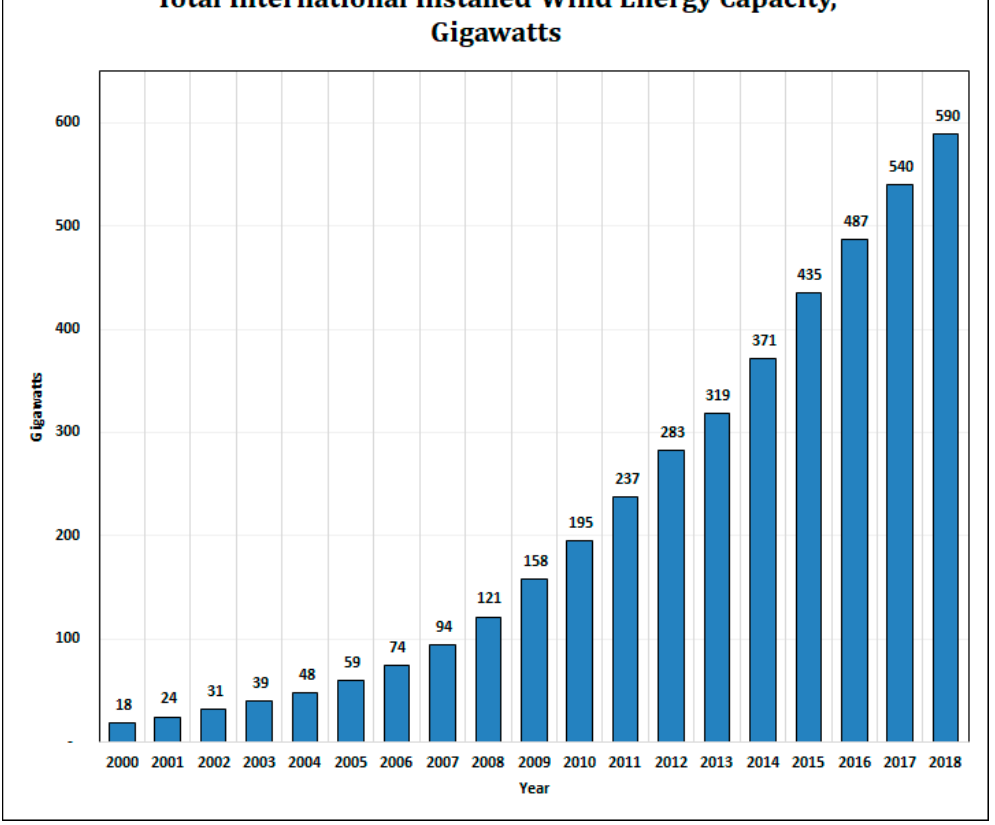
Figure 1. Global wind energy capacity growth. Data source: The Wind Power Statistics [19].